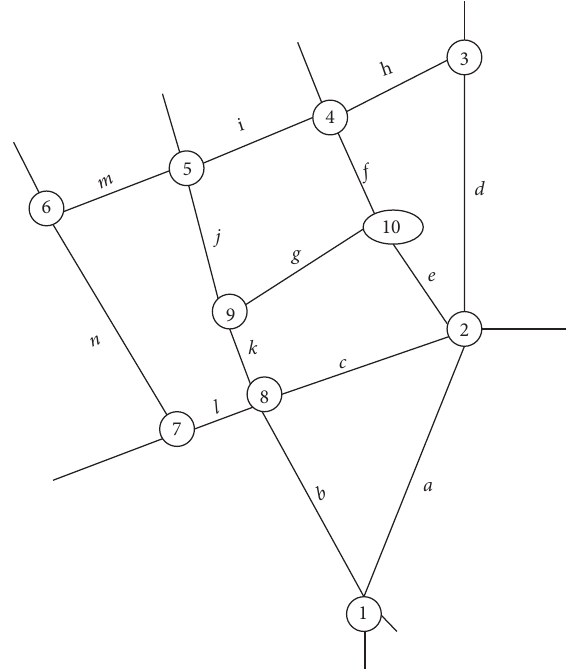
Figure 1: Experimental traffic network